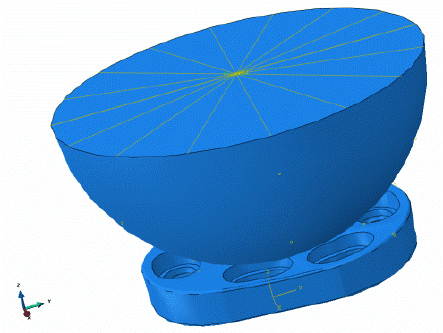
Figure 6. Modeling of the load for the FEM analysis.